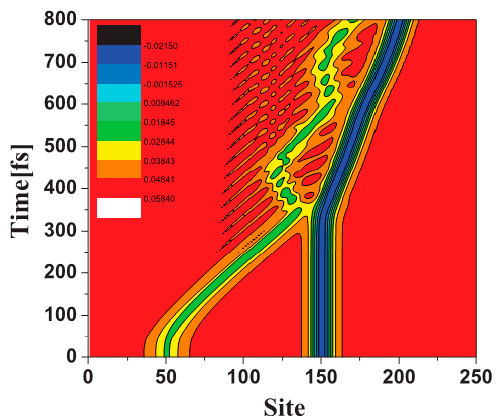
Figure 15. The evolution of polaron and triplet exciton lattice configuration under electric field with time by Su et al. [64] with the permission of Journal of Chemical Physics.